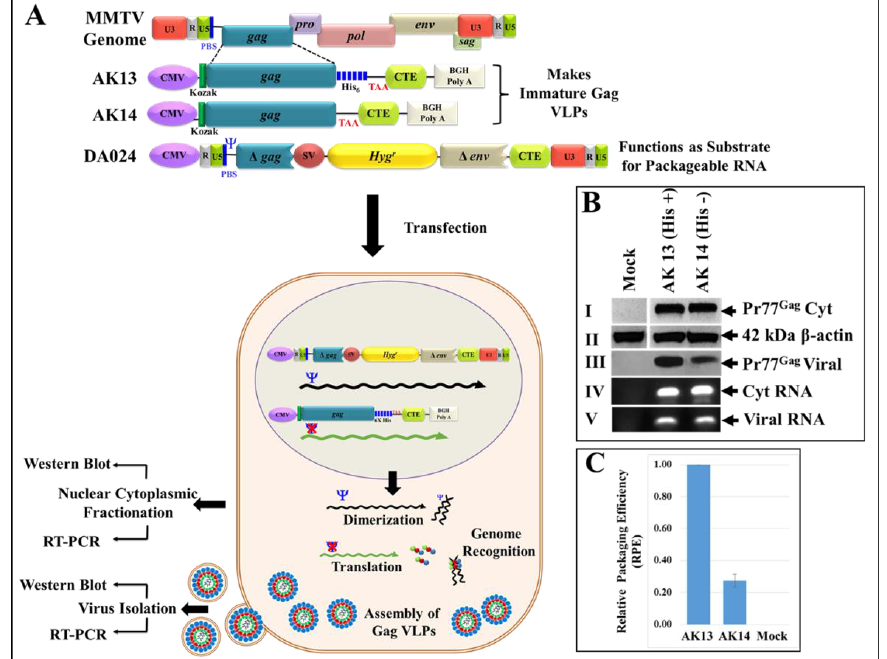
Figure 9. Schematic representation of the two-plasmid genetic complementation assay to demonstrate VLPs formation following Pr77 Gag -His 6 -tag protein expression in eukaryotic cells and their ability to package MMTV sub-genomic RNA. ( A ) Upper panel; MMTV full-length Gag eukaryotic expression plasmids and MMTV sub-genomic transfer vector, DA024 [29]. ( A ) Lower panel; Graphical representation of the MMTV two-plasmid genetic complementation assay in which VLPs produced by recombinant MMTV Pr77 Gag expression plasmids (AK13 and AK14) should package MMTV sub-genomic transfer vector (DA024) owing to the presence of the packaging sequences ( Ψ ). HEK 293T cells co-transfected with the two plasmids were subjected to nucleocytoplasmic fractionation. The cytoplasmic fractions and pelleted VLPs were analyzed for transfer vector RNA expression by RT-PCR; ( B ) western blots performed on cell lysates and ultracentrifuged transfected culture supernatants using α -MMTV p27 monoclonal antibody (panels I and III), and α - β -actin antibody (panel II), respectively. PCR amplification of cDNAs prepared from